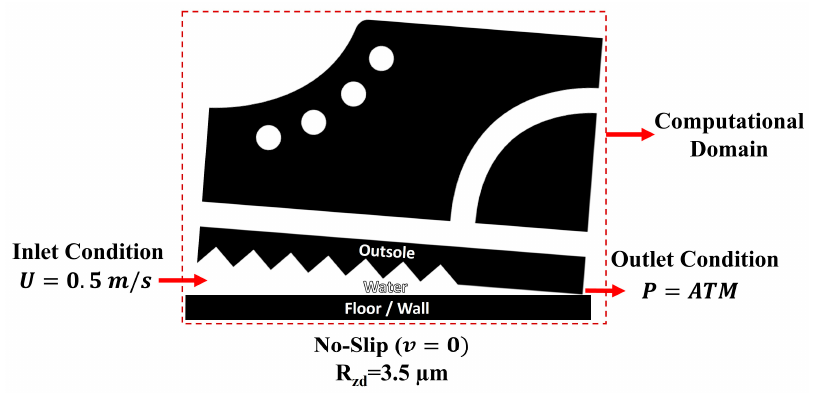
Figure 5. Computational domain and the boundary conditions used to simulate the wet slipping condition.